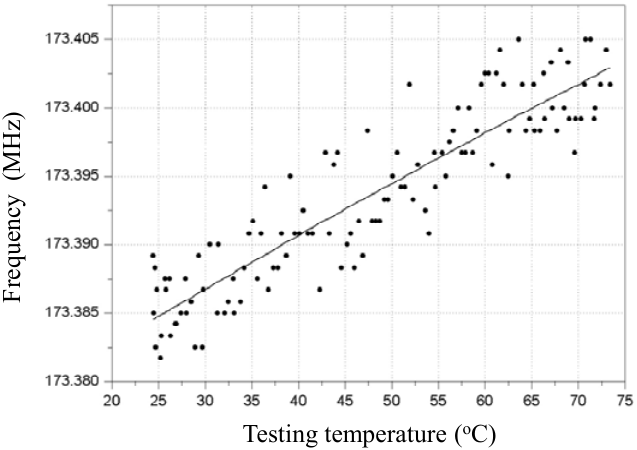
Figure 8. The time-dependent frequency response of the device #3.